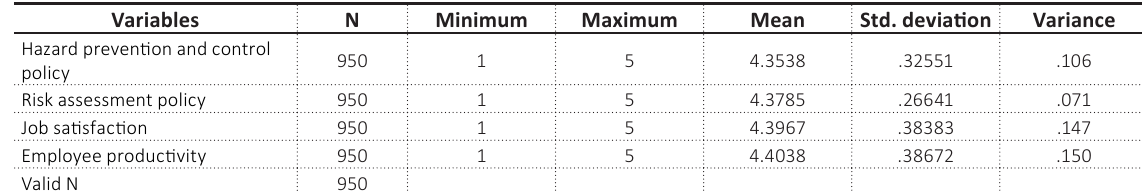
Table 1. Descriptive statistics of